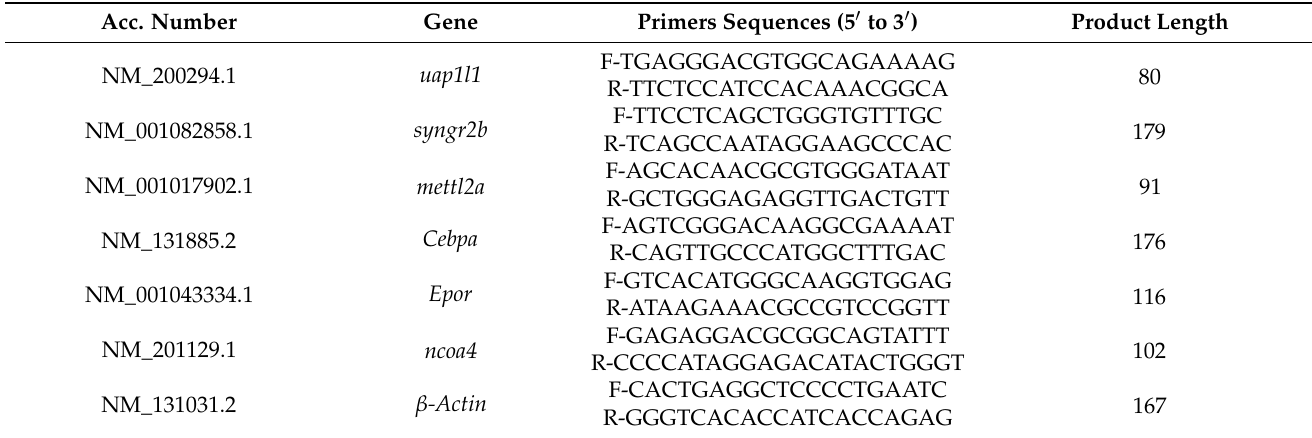
Table 1. Specific primers for the selected unigenes and reference